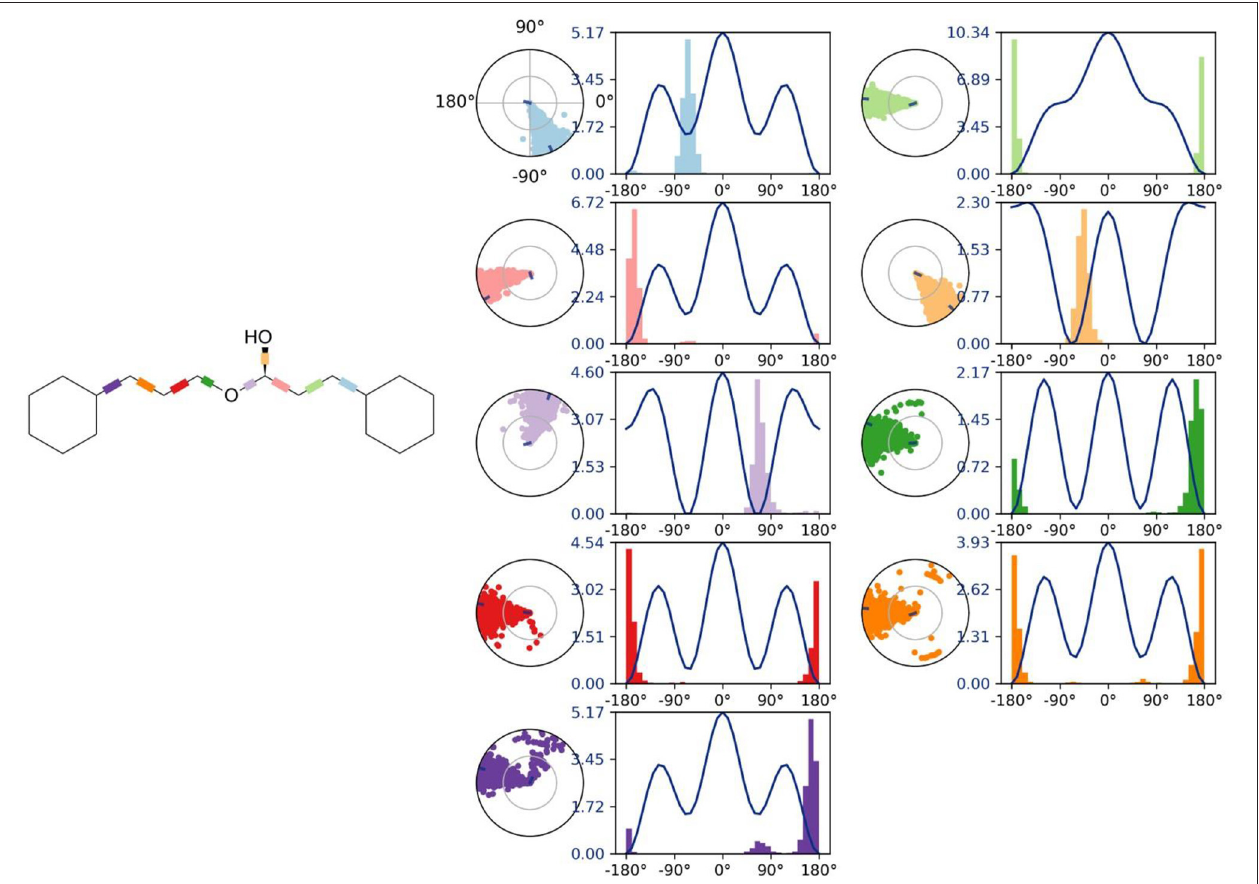
FIGURE 5 | Analysis of the torsional degree of freedom for the rotatable bonds present in cinnamyl dihydrocinnamate (CMNPD5348) during 100 ns of MD